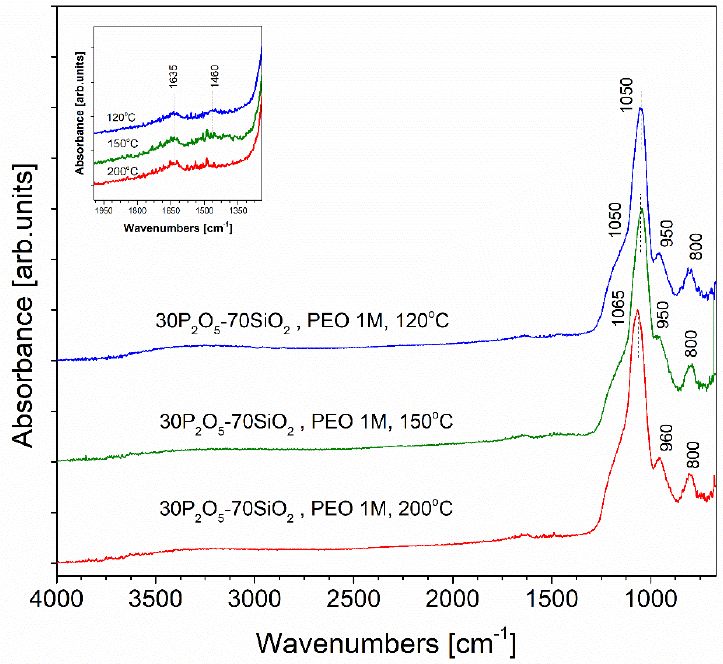
Figure 5. Fourier transformed infrared spectroscopy (FTIR) attenuated total reflectance (ATR) spectra recorded for PEO-doped samples annealed at temperatures of 120, 150, and 200 °C.